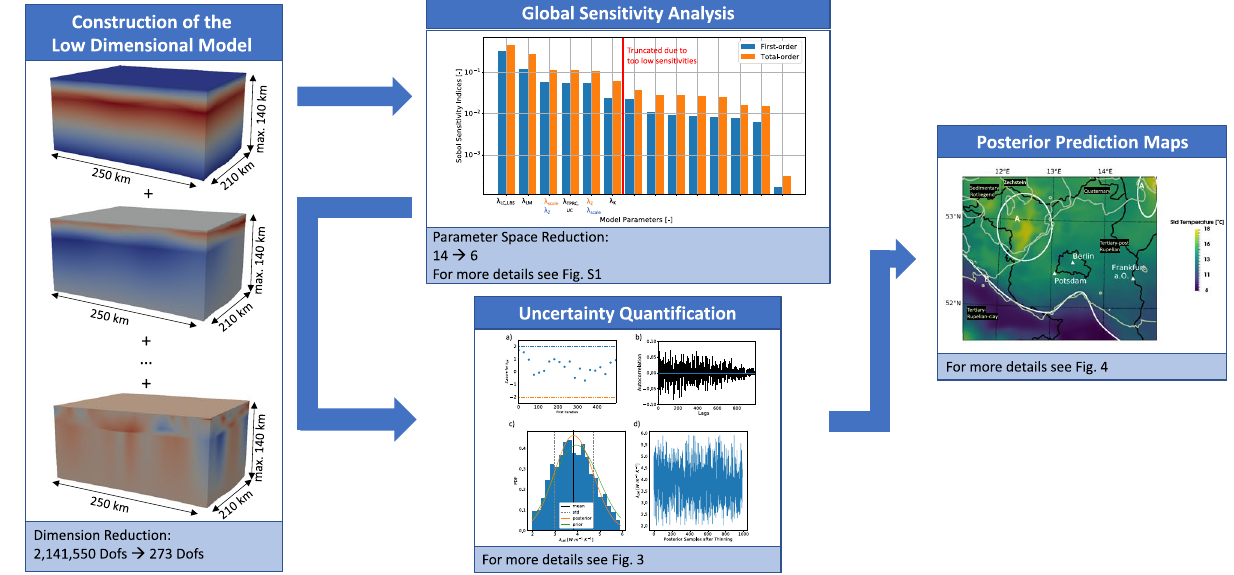
Figure 1. Schematic representation of the workflow. In the left panel, we show exemplarily the first, second, and last basis function of the surrogate (low dimensional) model. The top middle panel shows the results of the global sensitivity analysis (see also Figure S1), and the middle base panel shows the posterior analysis (see also Fig. 3). The right panel contains the posterior predictive map of the standard deviations highlighting three distinct model areas (see also Fig.